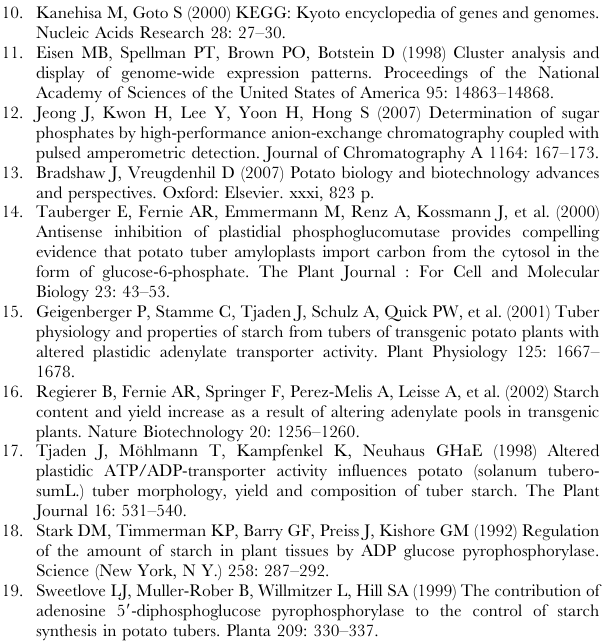
Table S1 List of gene IDs and gene names relevant for starch metabolism. Table S2 All tags and tag counts involved in starch metabolism. Table S3 Summed tag counts for multiple enzyme isoforms catalyzing a single step in starch metabolism.